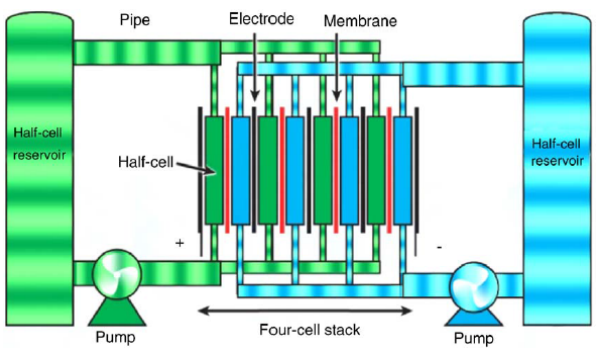
Figure 5. Schematic diagram of a flow battery [1,54].